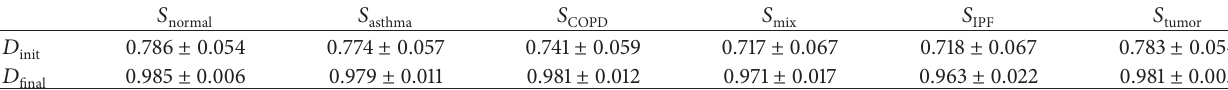
for each test set. FBA Aff